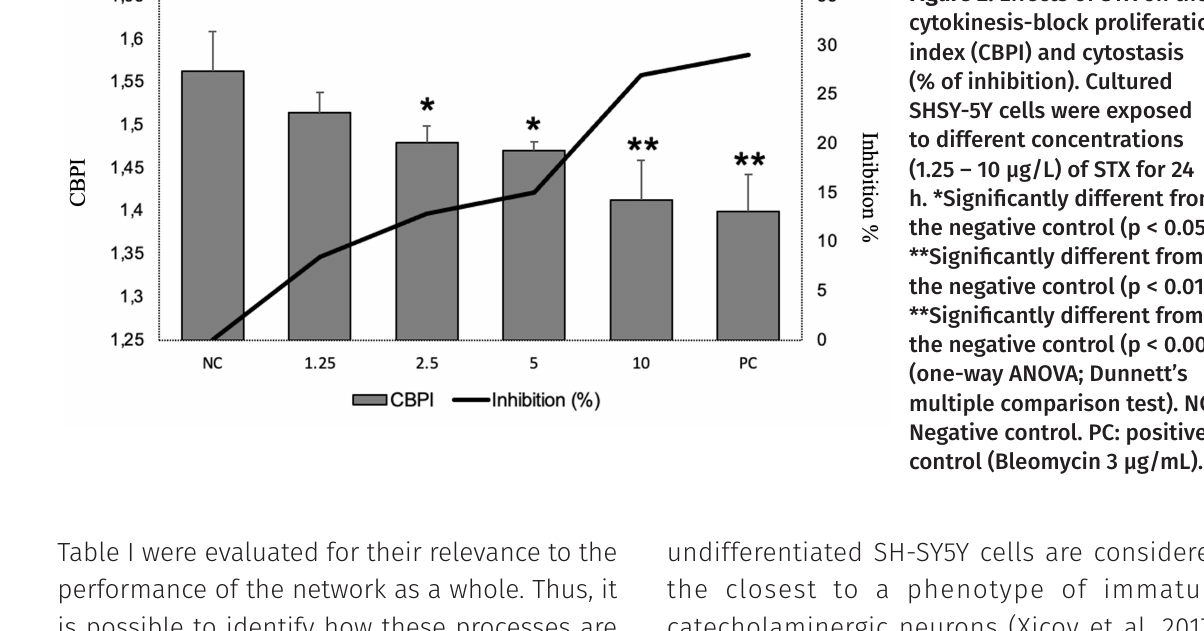
Figure 2. Effects of STX on